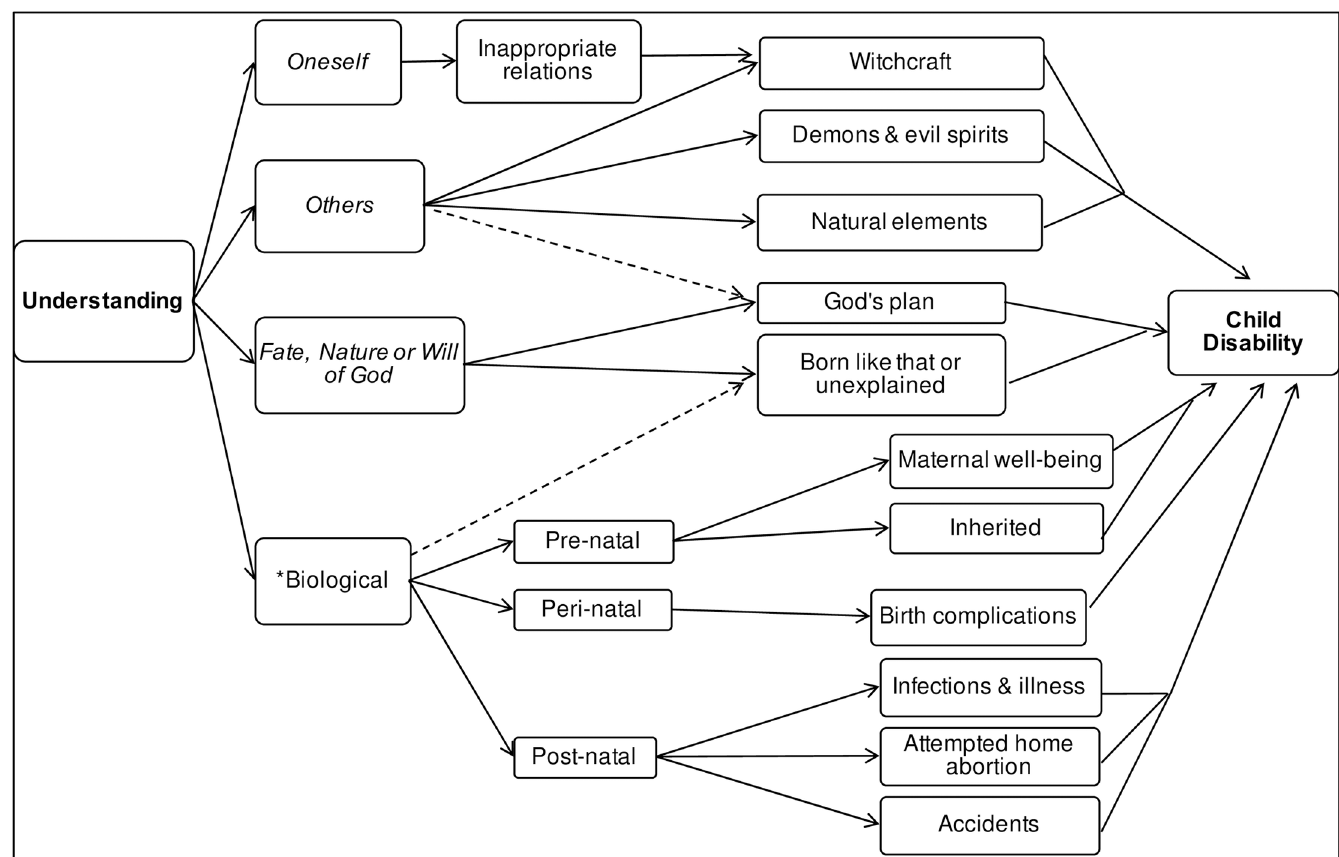
Fig 1. Thematic map summarising local understanding of childhood